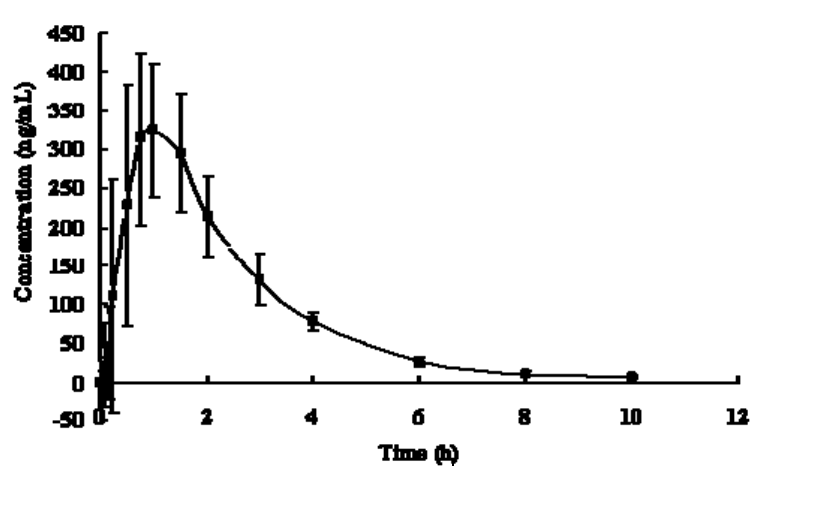
Figure 3. Mean plasma concentration-time profiles for MP in Beagle dogs after a single oral administration of MP tartrate tablets (2 pieces, 50 mg) ( SDx